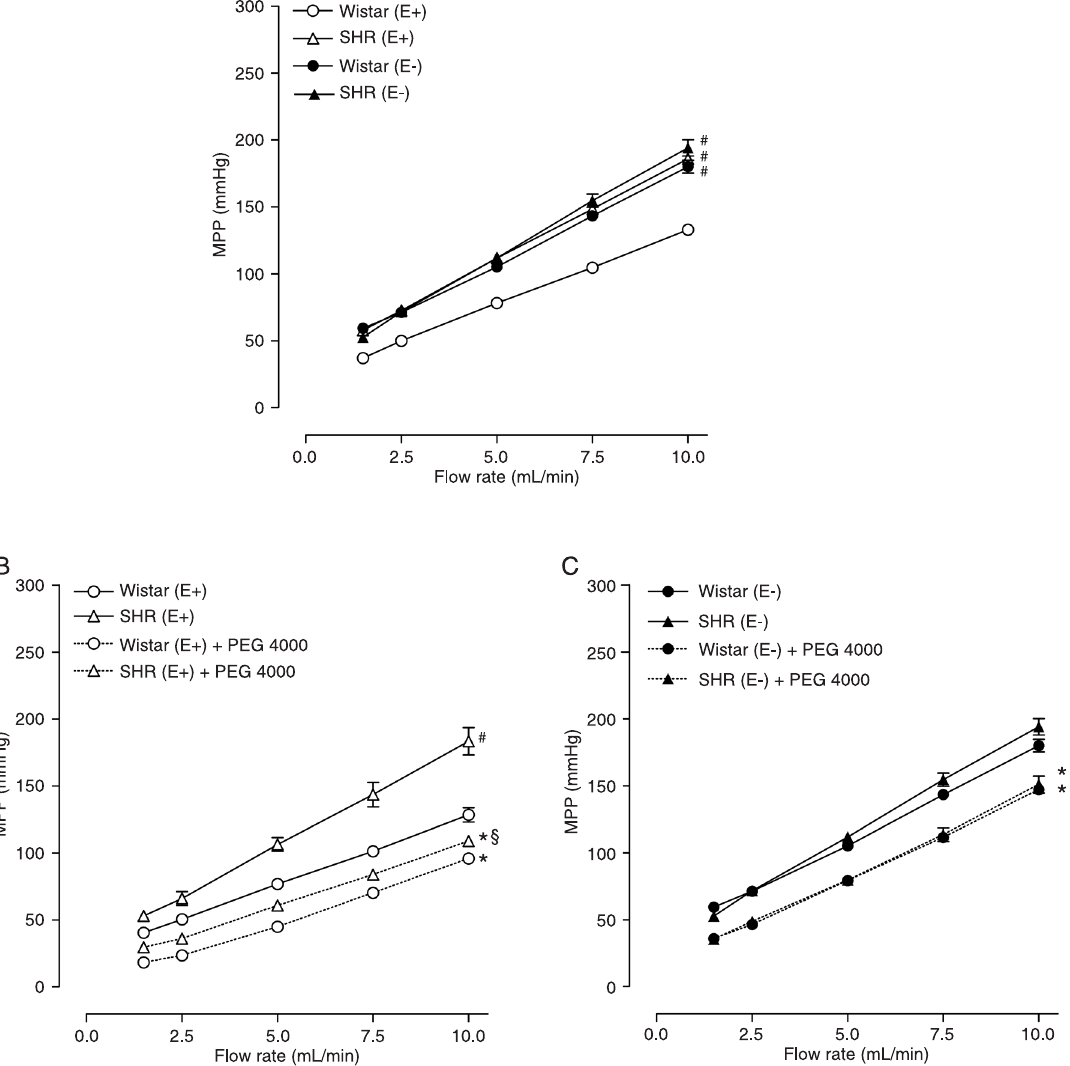
Figure 4. Flow-pressure relationship in tail arterial beds. A , Before (E+) and after (E-) endothelial damage on tail arterial beds from SHR (N = 7 animals) and Wistar rats (N = 6 animals); B , in the absence and presence of PEG 4000 in tail arterial beds with intact endothelium (E+) from SHR (N = 5 animals) and Wistar rats (N = 7 animals); C , effect of PEG 4000 after endothelial damage (E-) on tail arterial beds from SHR (N = 7 animals) and Wistar rats (N = 6 animals). MPP = mean perfu- sion pressure. # P < 0.05 vs Wistar; *P < 0.05 vs PEG effectiveness; § P < 0.05 interaction between PEG effect on Wistar rats and SHR (two-way ANOVA followed by the Bonferroni post hoc